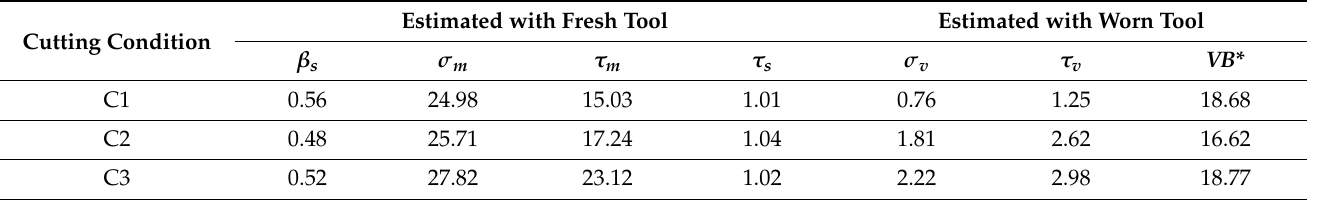
Table 4. Model parameters.